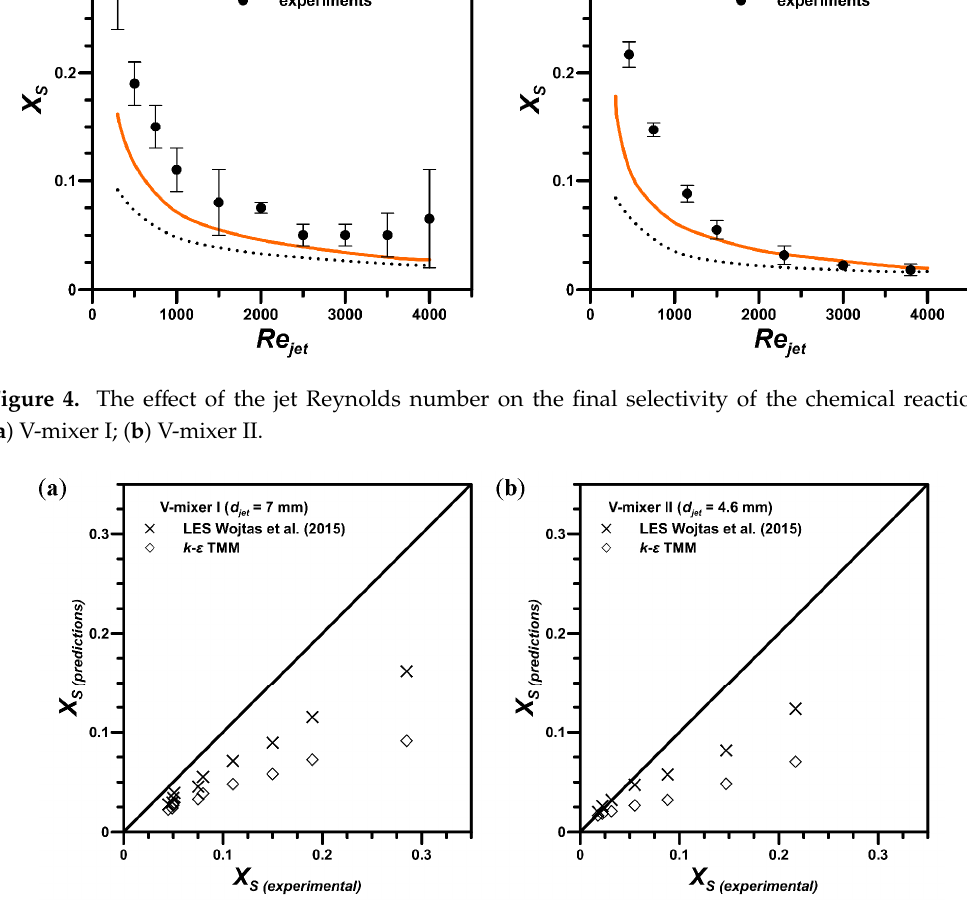
Figure 4. The effect of the jet Reynolds number on the final selectivity of the chemical reaction: ( a ) V- mixer I; ( b ) V-mixer II.